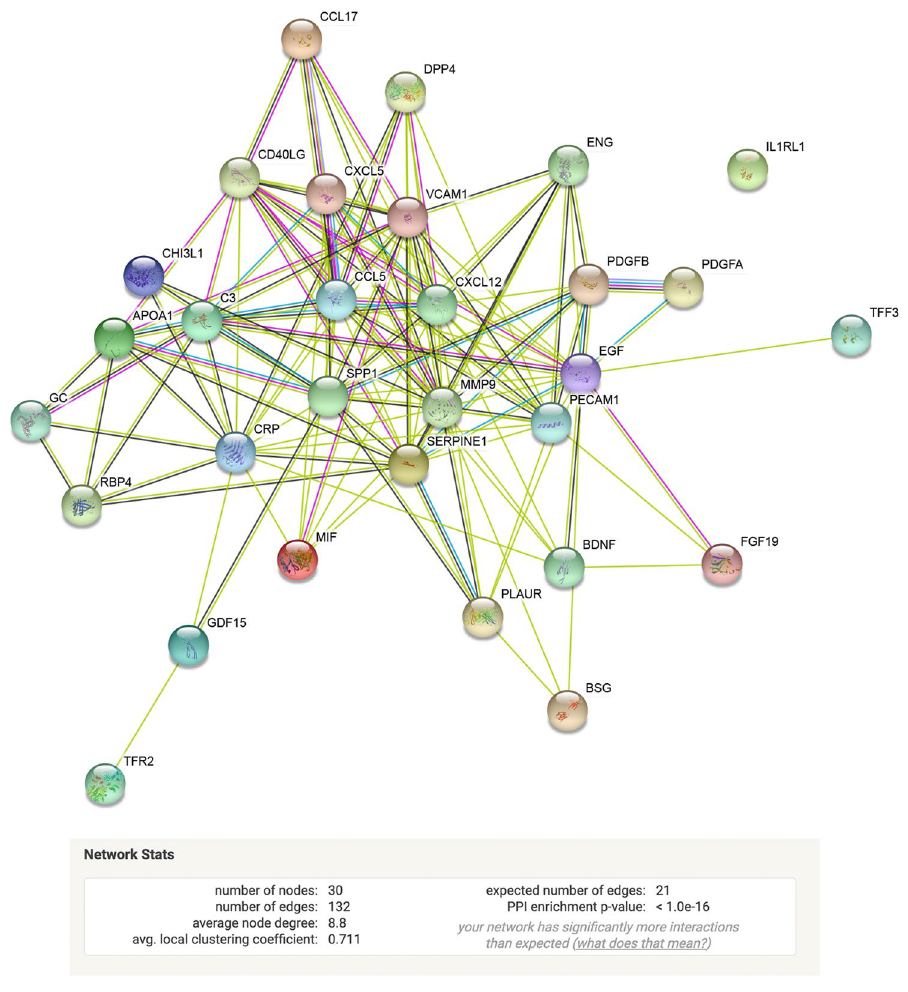
Figure 3. Interaction networks from significantly upregulated serum cytokines from cancer survivors. String diagram depicting molecular relationships, interactions, and pathway associations between significantly upregulated cytokines. Statistical significance for this analysis was established at p <